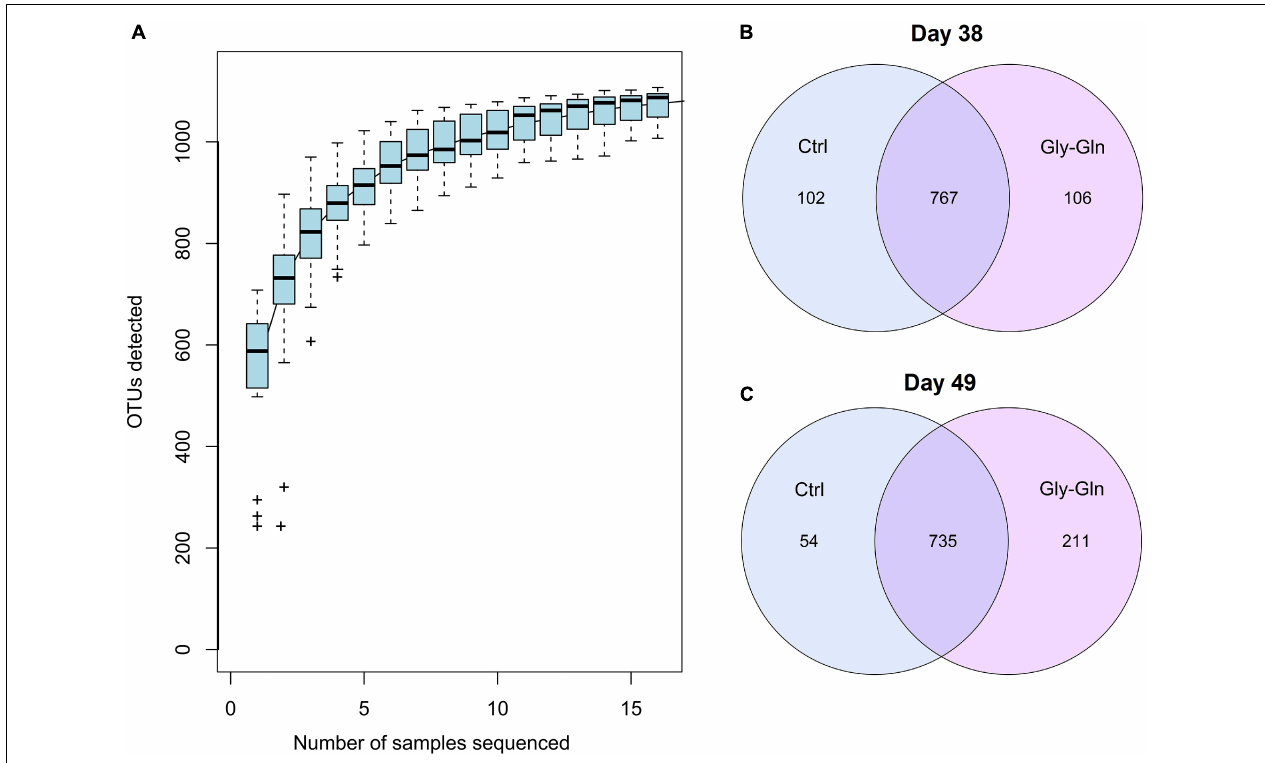
FIGURE 1 | The common/unique OTUs number between Gly-Gln group and Ctrl group. Species accumulation curves based on OTU (A) . Common/unique OTU number distribution on day 38 (B) and day 49 (C) ( n = 5).